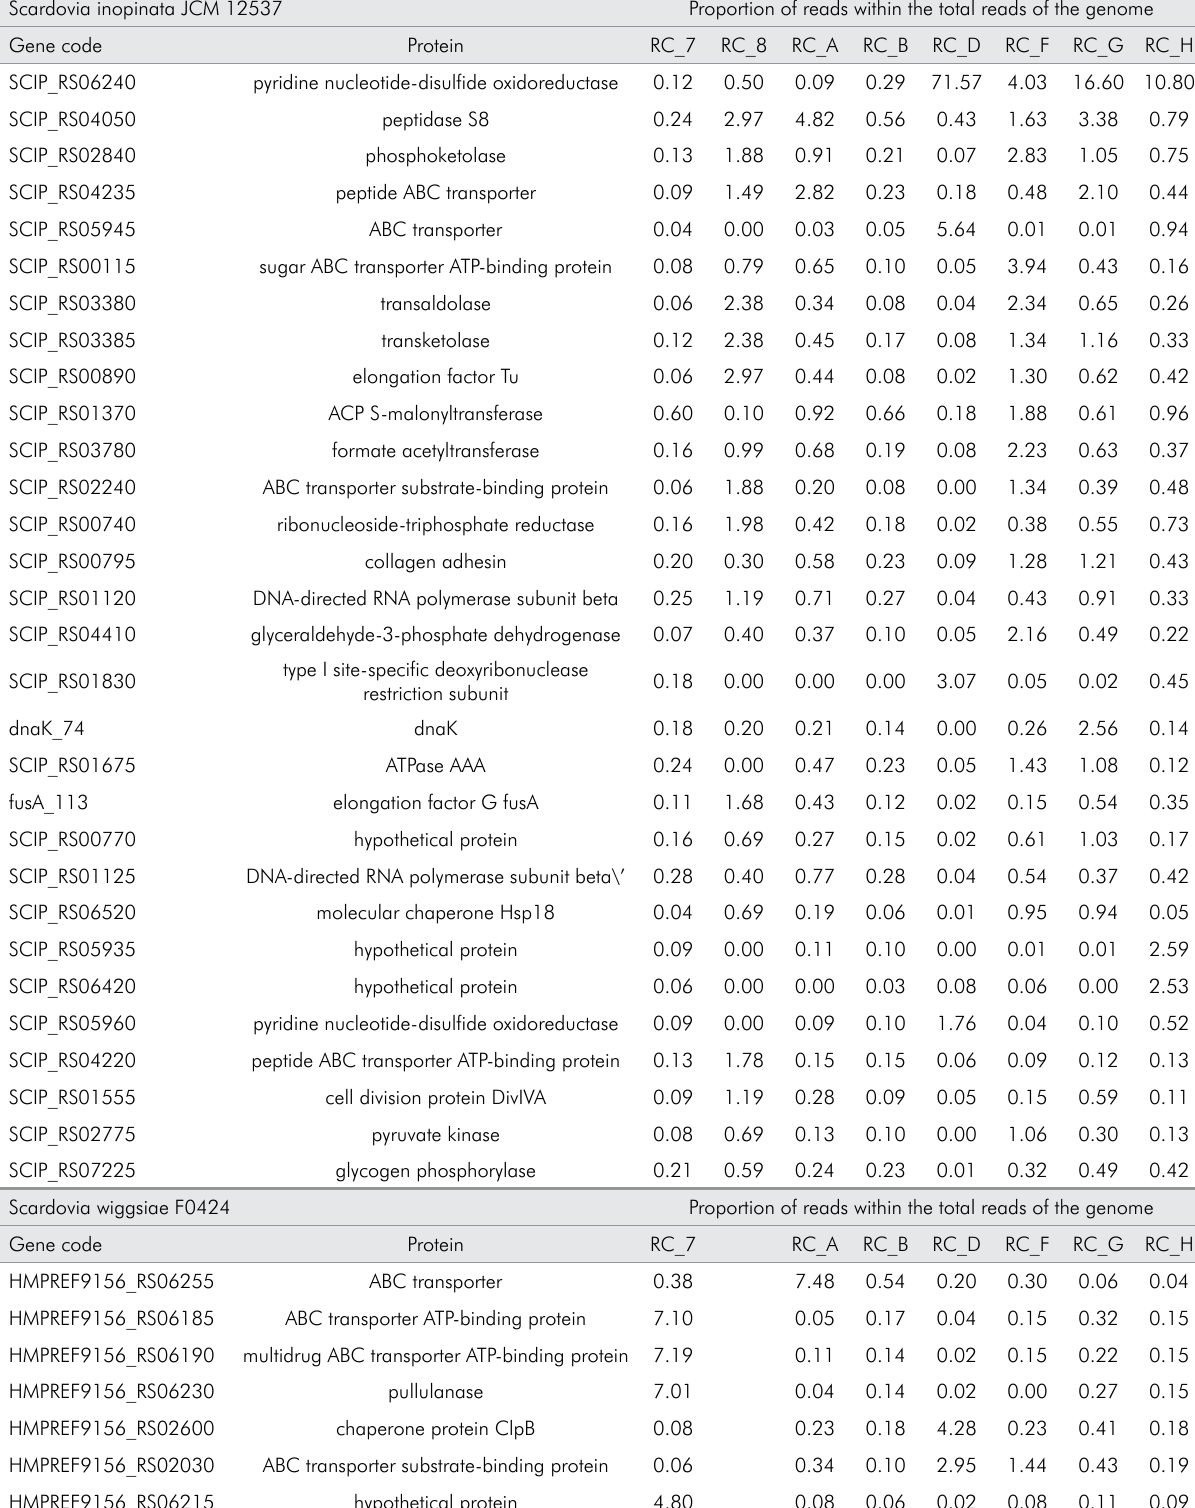
Table. Top 30 most expressed genes of Scardovia inopinata and Scardovia wiggsiae in root caries samples . Scardovia inopinata JCM 12537 Proportion of reads within the total reads of the